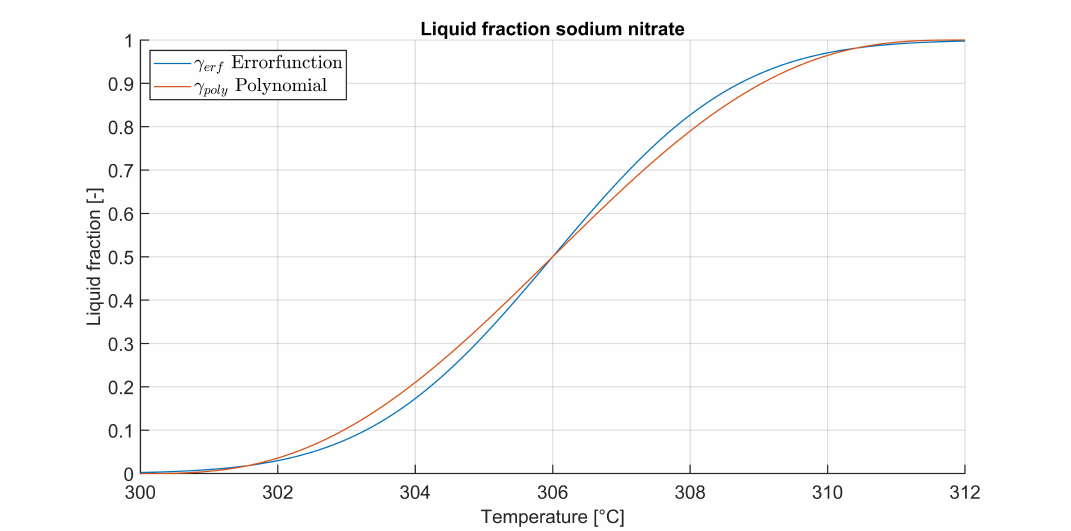
Figure 5. Liquid fraction γ comparison for sodium